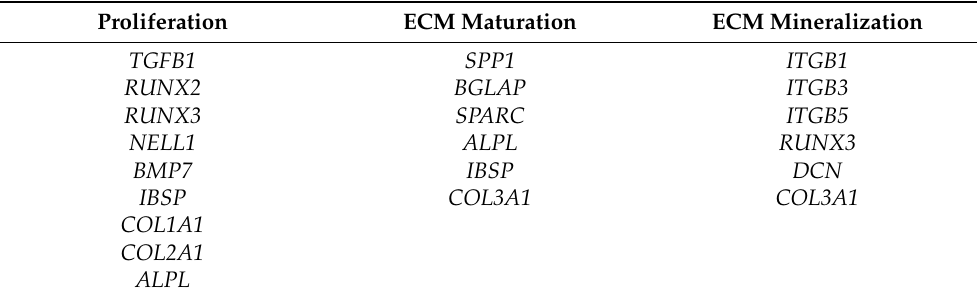
Table 1. Some of the bone related genes with the upregulation of expression during the three phases of osteoblast lineage cell growth and differentiation: Proliferation, ECM production and maturation, and ECM mineralization